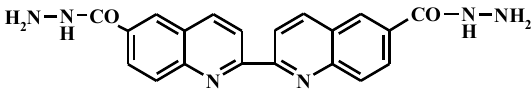
Figure 2. Synthesis of PHI.